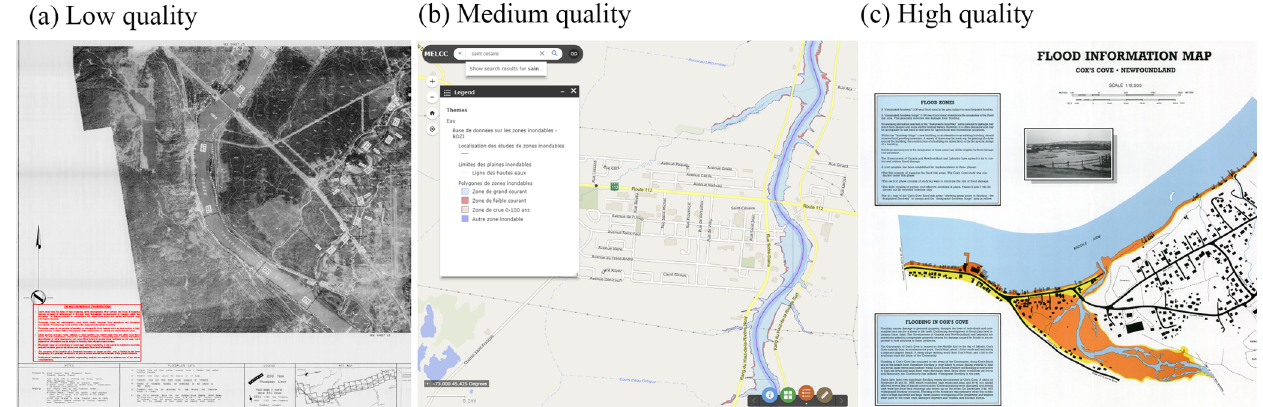
Figure 2. Comparison of flood maps and associated quality scores. (a) Barriere, British Columbia, score of 22% (two out of nine) for includ- ing a legend and limitations of flood modelling. (b) Saint-Césaire, Quebec, score of 44% (four out of nine) for including an address search, local context, legend, and legible flood zone. (c) Cox’s Cove, Newfoundland and Labrador, score of 78% (seven out of nine) for including identifiable buildings in the community, local context, legend, historical photographs and description, legible flood zone, explanation of technical terminology, and a brief description about flood risk reduction at the property level (e.g., building a barrier around a